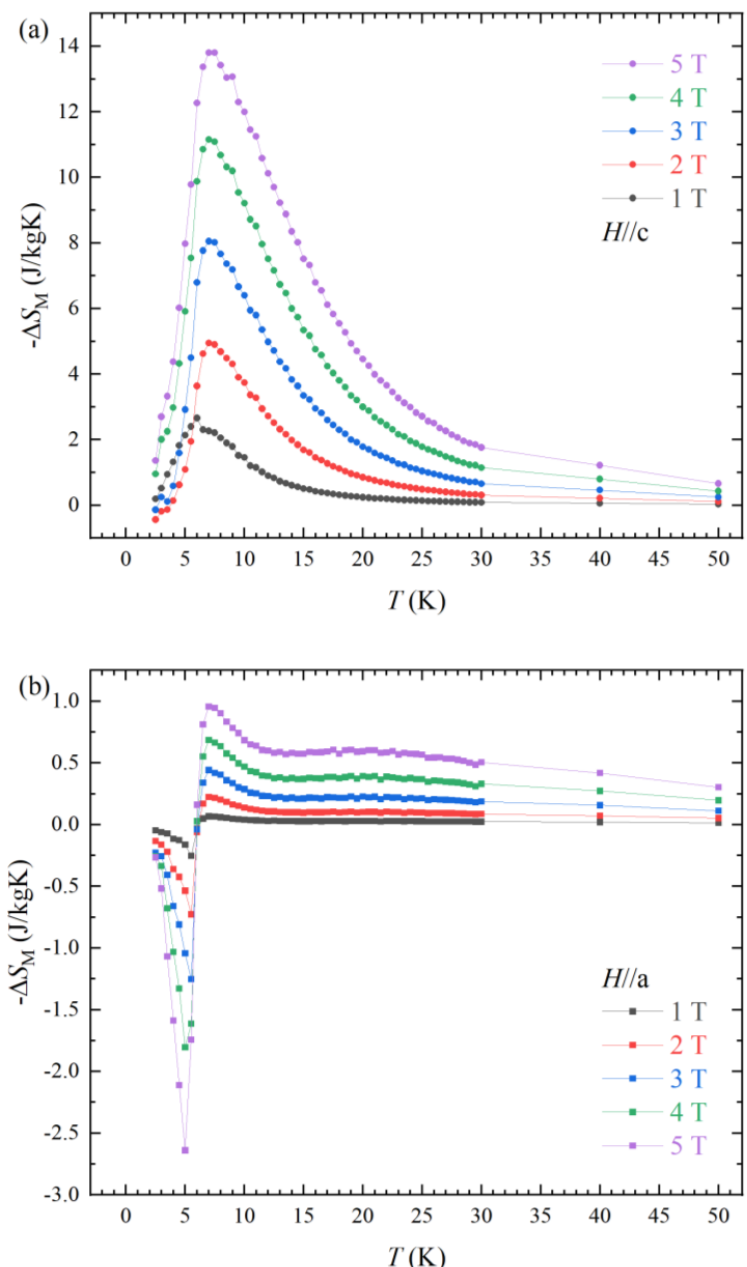
Figure 4. Entropy change − ∆ S M of NdAlGe along the H //c ( a ) and H//a ( b ) under various magnetic fields, as